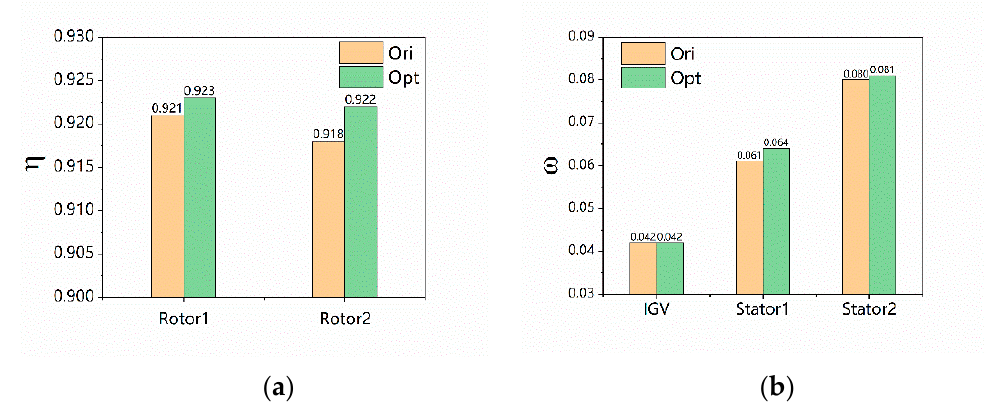
Figure 12. Rotor adiabatic efficiency and stator total pressure loss of the original and optimized compressor. ( a ) Rotor adiabatic efficiency at peak efficiency condition; ( b ) stator total pressure loss at peak efficiency condition.